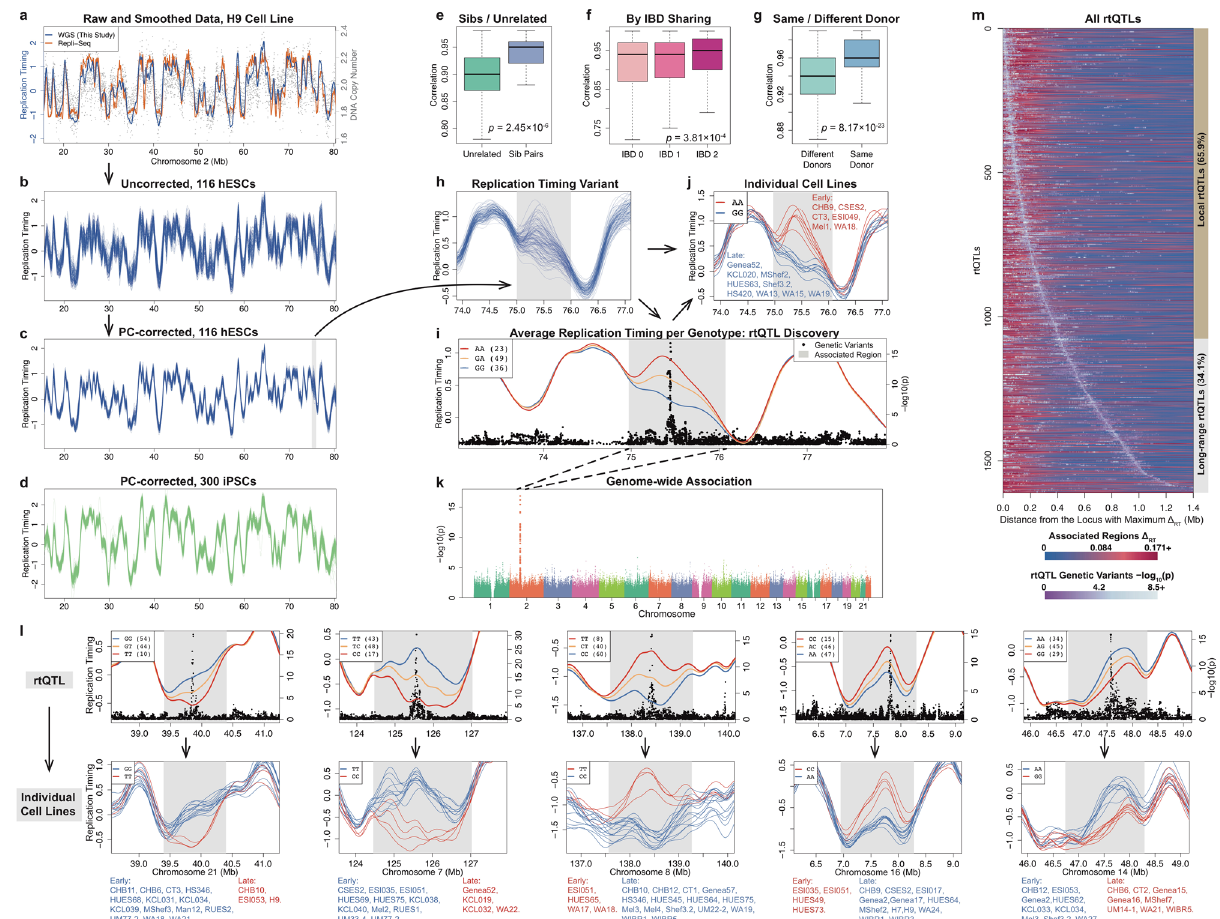
Fig. 1 The Human Genome ’ s Replication Timing Program is Extensively Encoded in DNA. a Replication timing (blue line; Z -score) inferred from read depth fl uctuations (gray) for the H9 cell line. Orange: Repli-Seq data for H9 74 . b Replication timing pro fi les are highly reproducible among samples. c , d PC- correction improves replication pro fi le accuracy. e – g Genetic relatedness associated with replication timing similarity. e Sibling vs. unrelated hESCs (two- sided Wilcoxon rank-sum test). n = 5754 (pairs of genetically unrelated samples), n = 24 (pairs of genetic siblings). f Genomic regions strati fi ed by increasing identity-by-descent (ANOVA). n = 14,856 (pairs of genomic regions with IBD 0), n = 7010 (pairs of genomic regions with IBD 1), and n = 262 (pairs of genomic regions with IBD 2). g iPSCs from the same or different donors (two-sided Wilcoxon rank-sum test). n = 44,742 (pairs of iPS cell lines from different donors), n = 108 (pairs of iPS cell lines from the same donor [derived separately]). For panels e , f , and g , top and bottom whiskers denote the maximum and minimum value, respectively. The top and bottom boxes denote the third and fi rst quartile, respectively. Center denotes the median. Outliers removed using R boxplot option “ outline = F ” . b A genomic region (gray) with inter-individual replication timing variation. i – k Genetic association reveals rtQTLs. i A haplotype strongly associated with the replication timing variant from panel h (panel k genome-wide association). Mean replication timing (left Y axis) for individuals with different genotypes at rs12713840, the top SNP, demonstrates that SNPs in cis (right Y axis) associate with replication initiation. Gray: affected region. j Replication timing at the variant from panel h , stratifying individuals by rs12713840 genotype. Genotype is the main determinant of replication timing variation. l Additional rtQTL examples. m All rtQTLs. Each horizontal line is an rtQTL, oriented from the replication timing locus with maximum difference between genotypes ( Δ RT ), showing the averaged replication timing difference on both sides of that locus. Foreground (gray-purple) shades: rtQTL SNPs, color-coded by p values, and placed according to their distance to the locus of maximal Δ RT . Most rtQTLs in fl uence surrounding genomic region ( “ local ” ), while a subset show long-range rtQTLs mapped to within 10 SNPs and 36 rtQTLs mapped to no more than three SNPs. rtQTL mapping was cross-validated